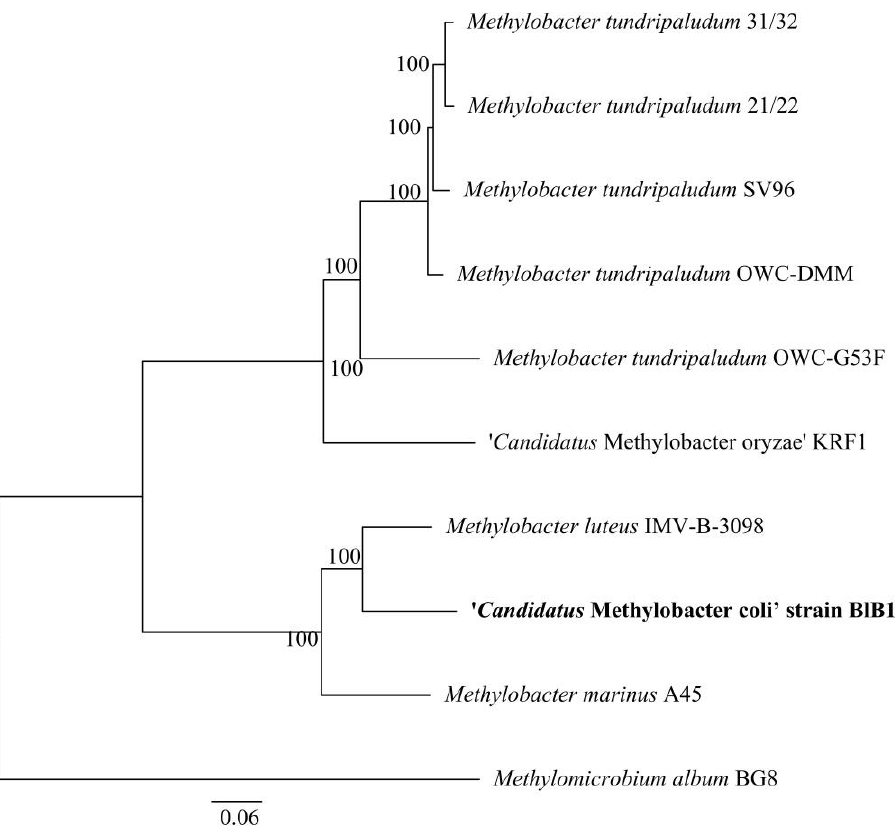
Figure 4. Phylogenomic tree constructed using the PATRIC database showing the relationship of ‘ Ca. Methylobacter coli’ strain BlB1 with other species of Methylobacter with an outgroup. The general characteristics of the draft genome of strain BlB1 are listed in Supplementary Table S1. The NCBI accession number and the Bioproject of BlB1 draft genome are JADMKV01 and PRJNA675424, respectively (https://www.ncbi.nlm.nih.gov/ge-